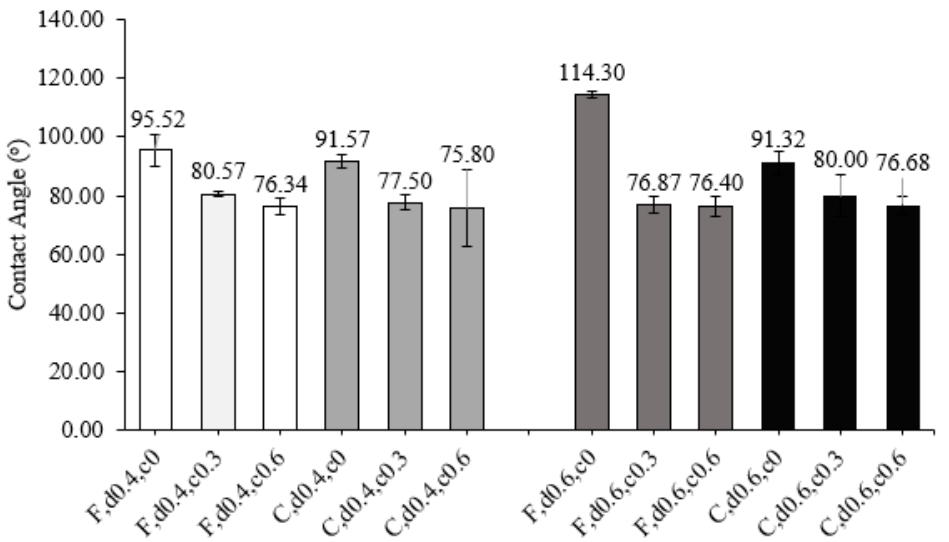
Figure 6. Contact angle (CA) values of bamboo particle board at various PU coating thickness with difference particle size and board density at 0 s. Table 3. Analysis of variance (ANOVA) of multiple regression for the effect of PU coating thickness, different particle size, and board density on the contact angle (CA) values.